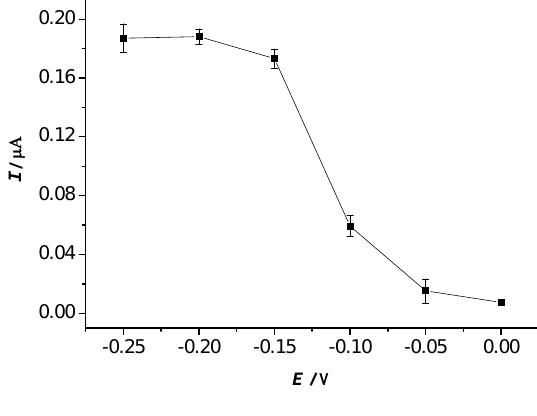
Figure 4. Effect of the working potential on the biosensor response for 5.0 × 10 -4 M H in 0.15 M pH 8.0 PBS containing 6.0 × 10 -4 M